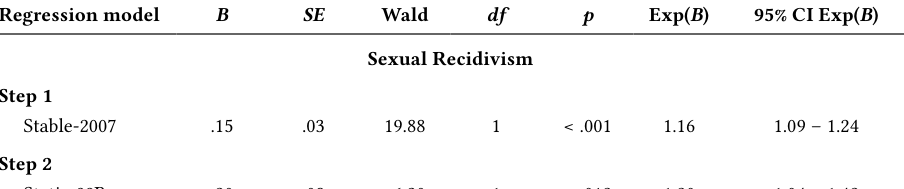
Sample 2: Cox Regression Analysis for Stable-2007 and Recidivism Regression